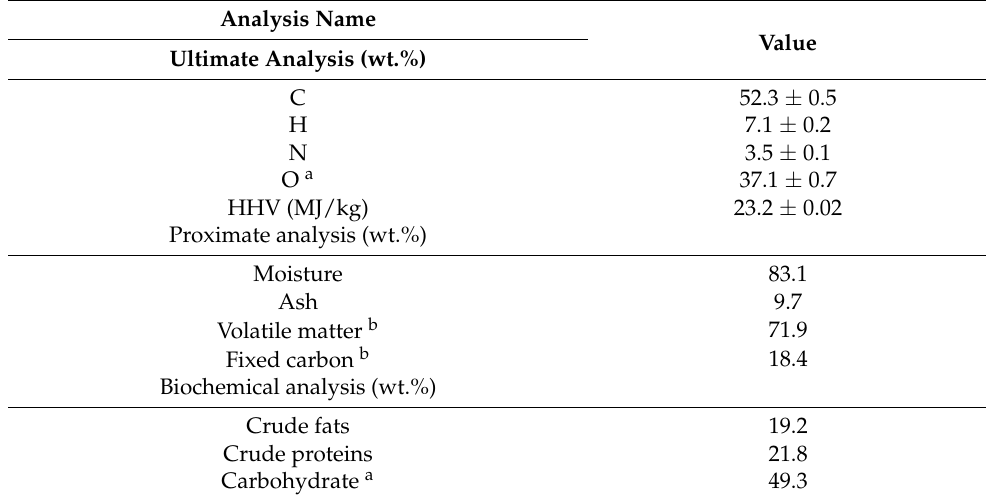
Table 1. Ultimate, proximate, and biochemical composition analysis of the